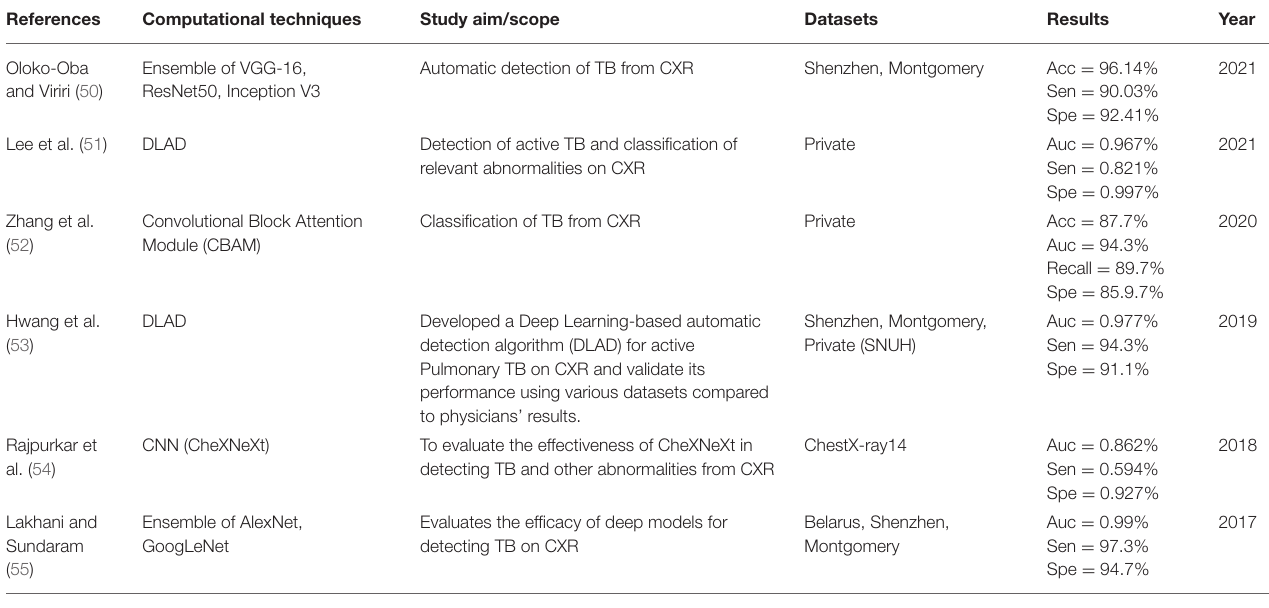
TABLE 4 | IEEE Xplore search